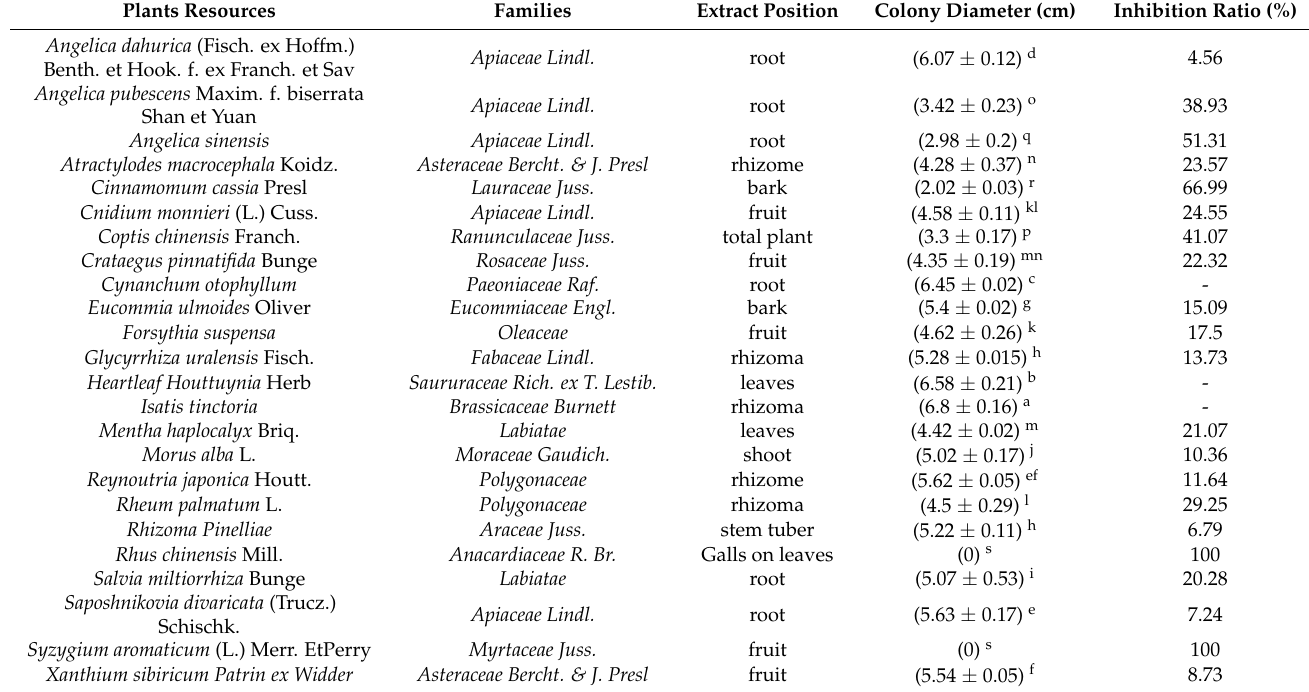
Table 1. Inhibition effects of ethanol extracts from plants against R.solani .